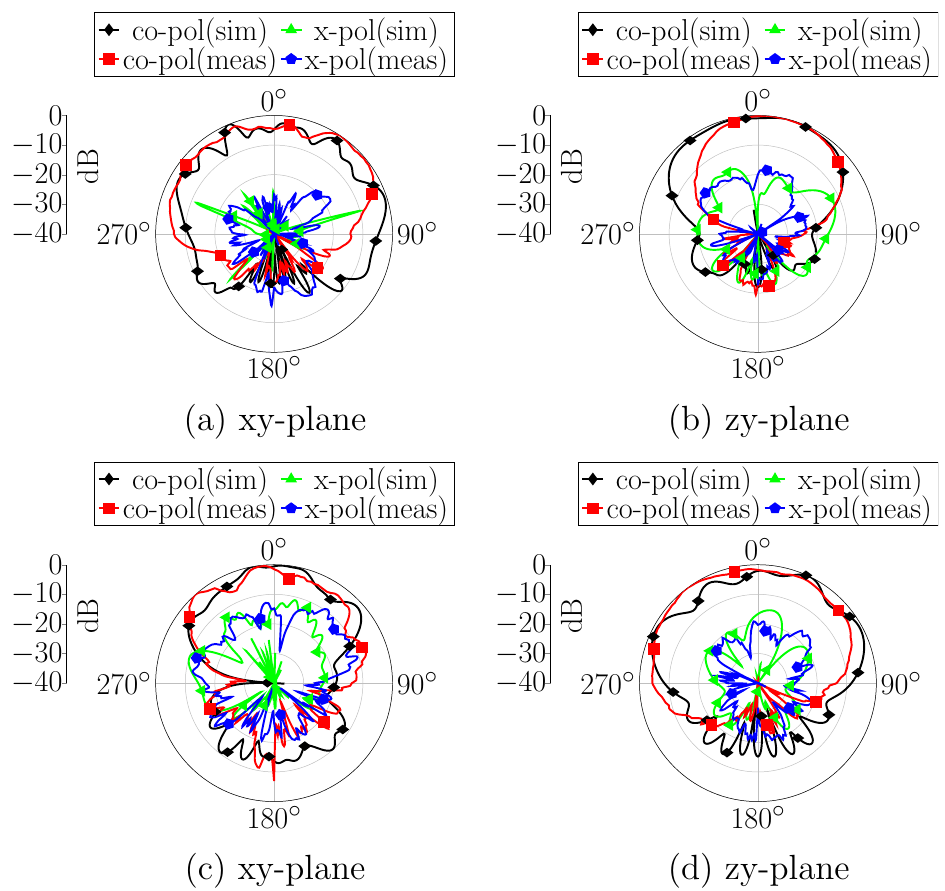
Figure 13. Radiation pattern of SIW integrated antenna, ( a , b ) represent port 1, ( c , d ) represent port